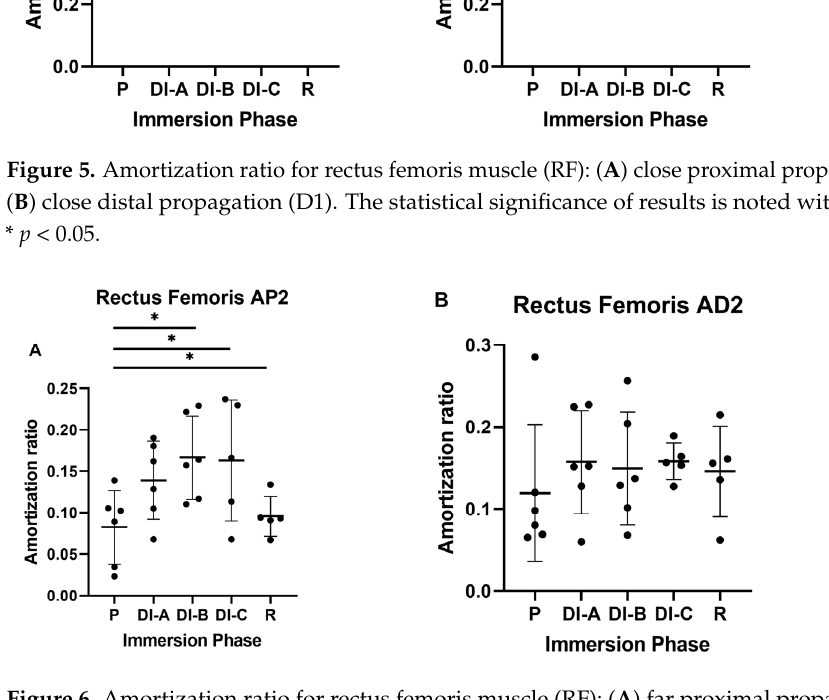
Figure 7. Amortization ratio for Sol: ( A ) close proximal propagation (P1) and ( B ) close distal prop- agation (D1). The statistical significance of results is noted with an asterisk (*): * p < 0.05. For the P2 accelerometer (Sol_AP2) shown in Figure 8A, the increase of the AR was significant after prolonged DI. Compared to P = 0.142 ± 0,07, the values increase signifi- cantly ( p < 0.05): DI-C = 0.282 ± 0.02 and R = 0.251 ± 0.05. For the D2 accelerometer, for all intervals of DI (DIA = 0.297 ± 0.01, DIB = 0.305 ± 0.05, DIC = 0.290 ± 0.10, and R = 0.285 ± 0.05), we observed significant increases versus P = 0.177 ± 0.05. ( p < 0.05).